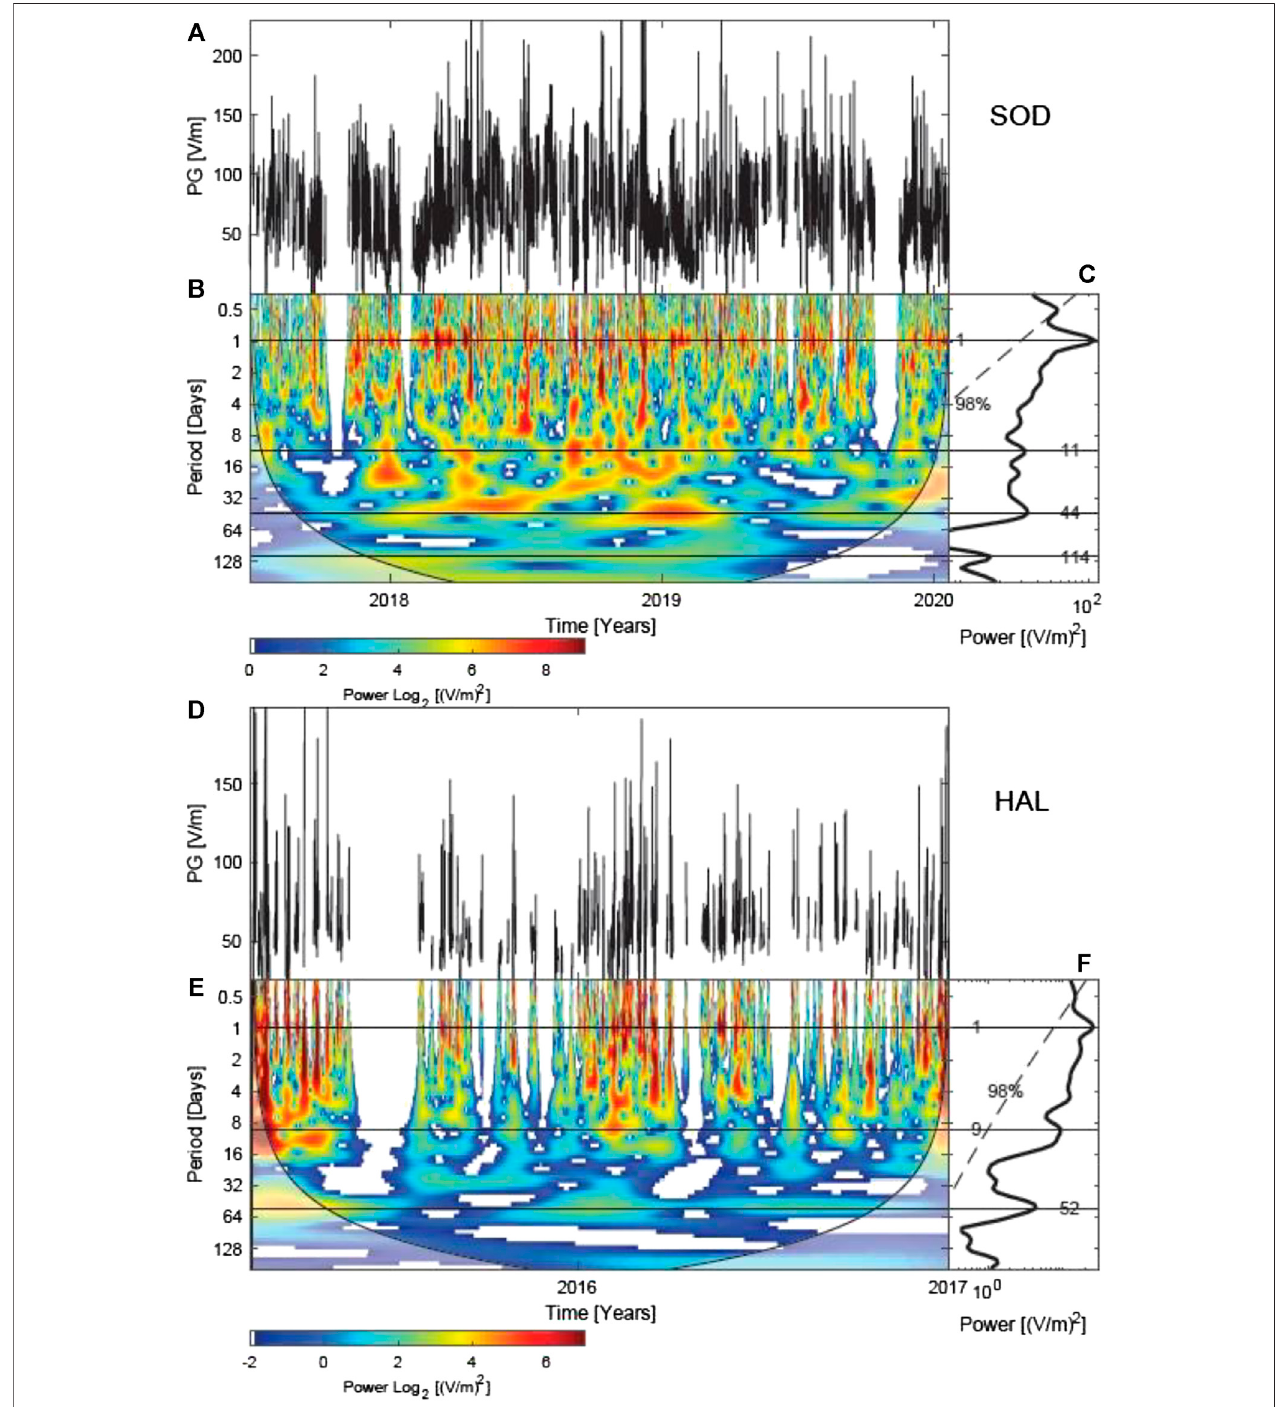
FIGURE 8 | Wavelet analysis for SOD and HAL stations. (A,D) Hourly average of the PG amplitude. Gaps are missing data. (B,E) Contours in the time – period domainoftherealpartofthewaveletpowerspectraofPG.Thecontourcolorsindicatetheminimumandmaximummagnitude,frombluetored,ofthematchesbetween the phases of the time series and the wavelet. The white shadowed lateral edges are values within the cone of in fl uence. (C,F) The global wavelet power spectrum. The horizontal lines indicate the most signi fi cant oscillations and the dashed curve is the 98% con fi dence.